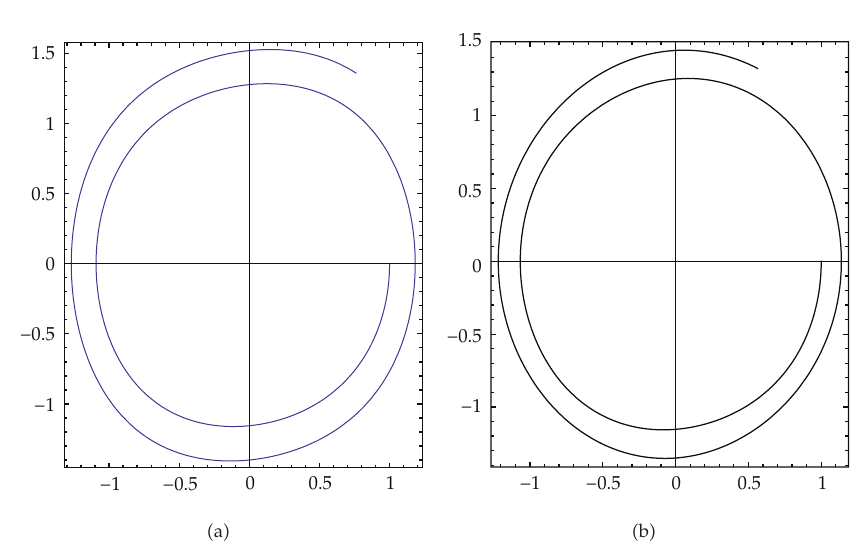
Figure 3: Comparisons for u versus ˙ u trajectory of the Du ffi ng-van der pol equation (cid:8) a (cid:9) RK4, (cid:8) b (cid:9) present